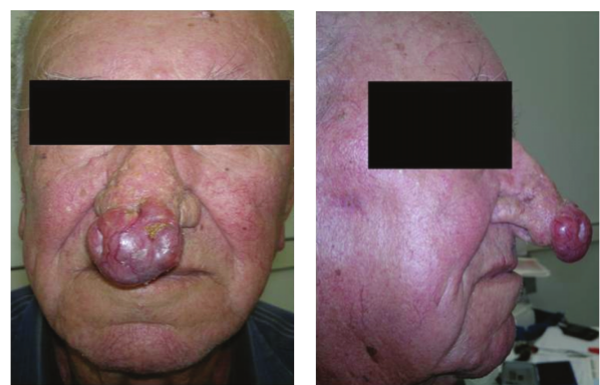
Figure 1: Rhinophyma at presentation.